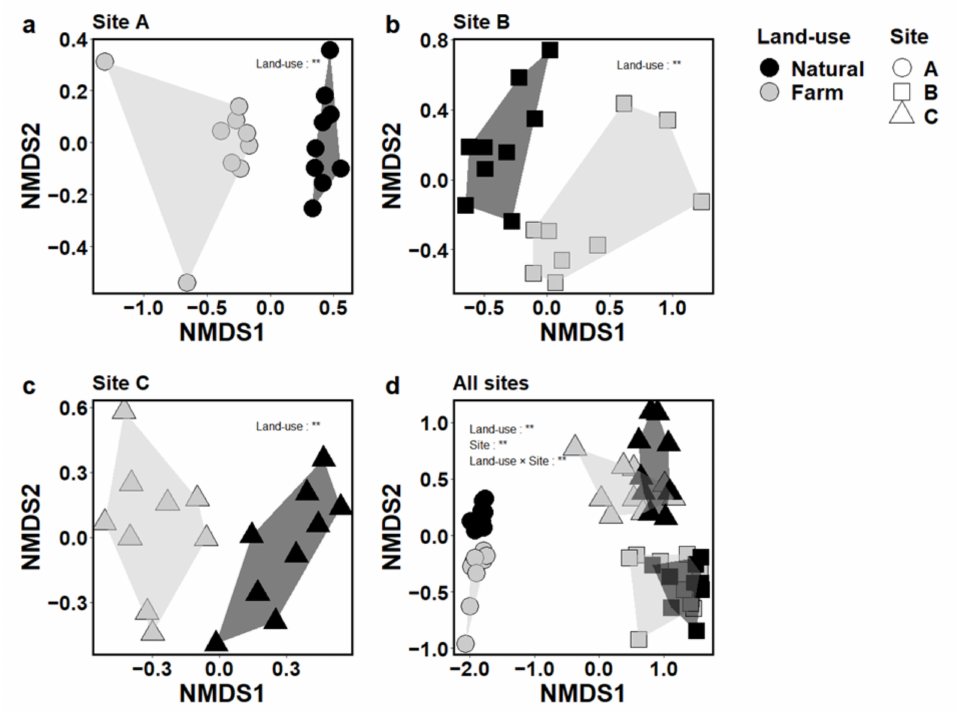
Figure 3. Difference in 16S rRNA community structures: ( a – c ) NMDS plots of the 16S rRNA commu- nity structures in each site at OTU level. The effect of land-use change was tested with PERMANOVA; ( d ) These communities of all sites are plotted in a same scaling with the result of PERMANOVA. The significances are shown as **, representing p <